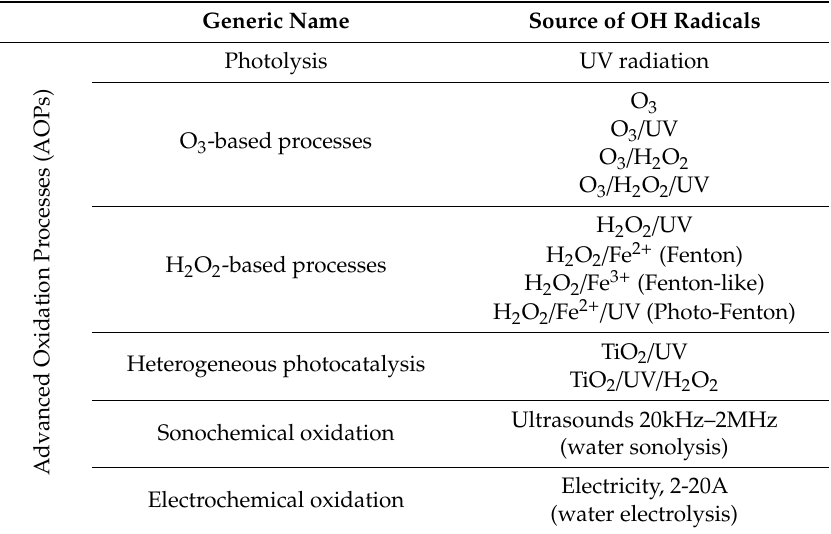
Table 3. A classification of advanced oxidation processes (AOPs) according to the source of · OH